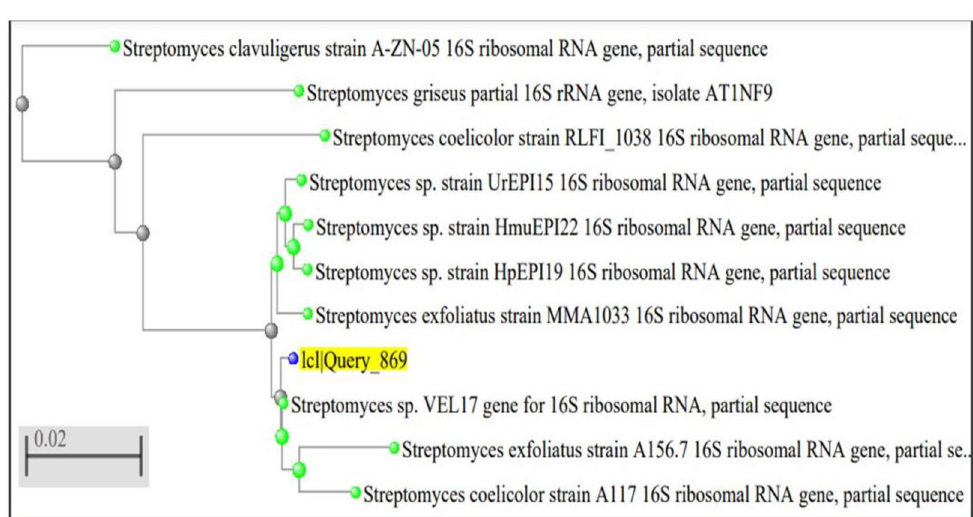
Fig 5. Phylogenetic analysis of Streptomyces exofoliatus MUJA10 strain isolate using 16S rRNA genetic sequencing.